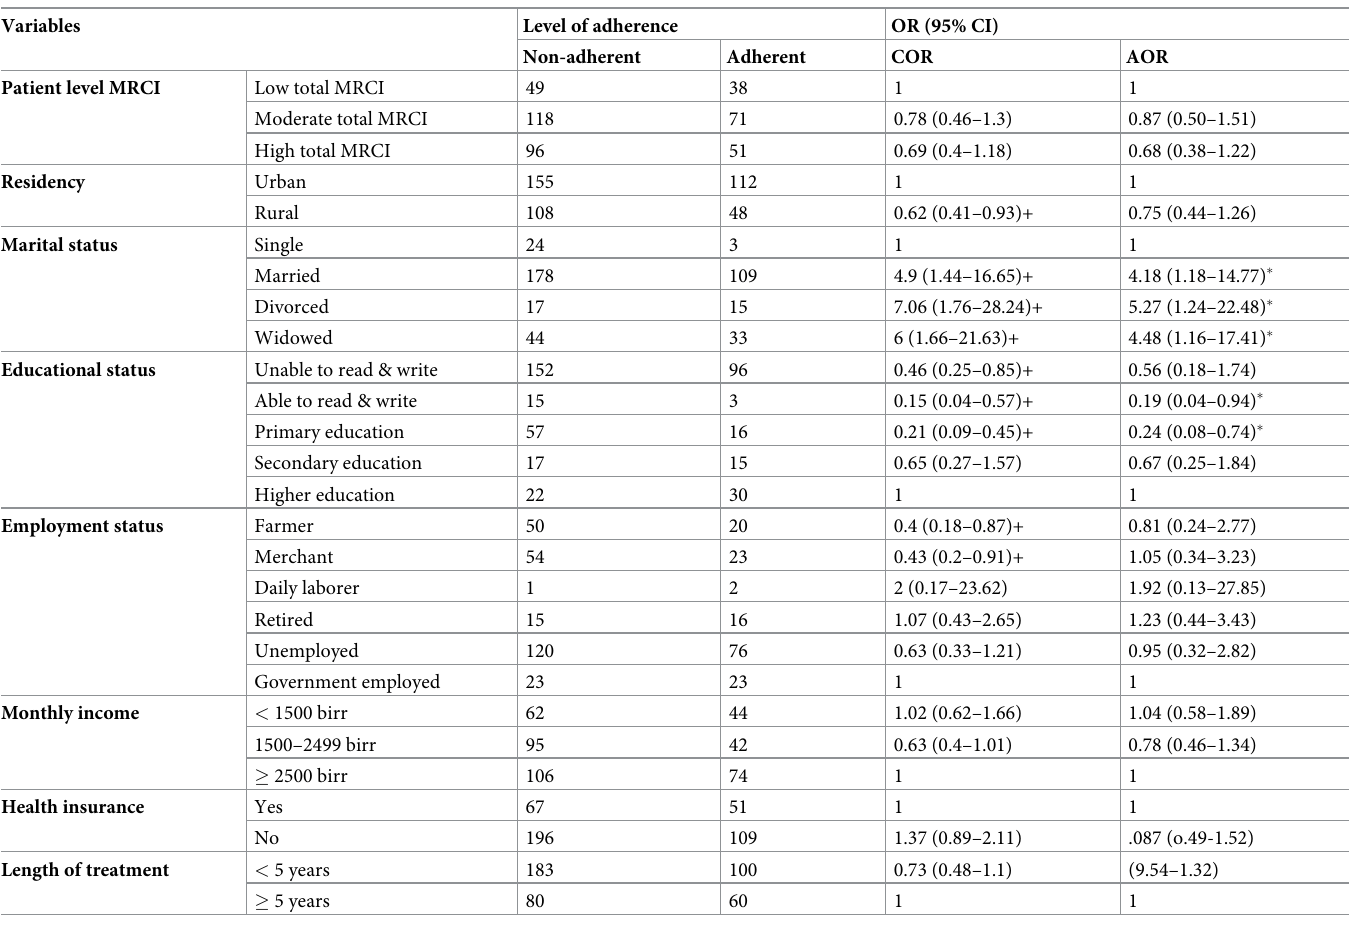
Table 3. Determination of the association between predictive variables and